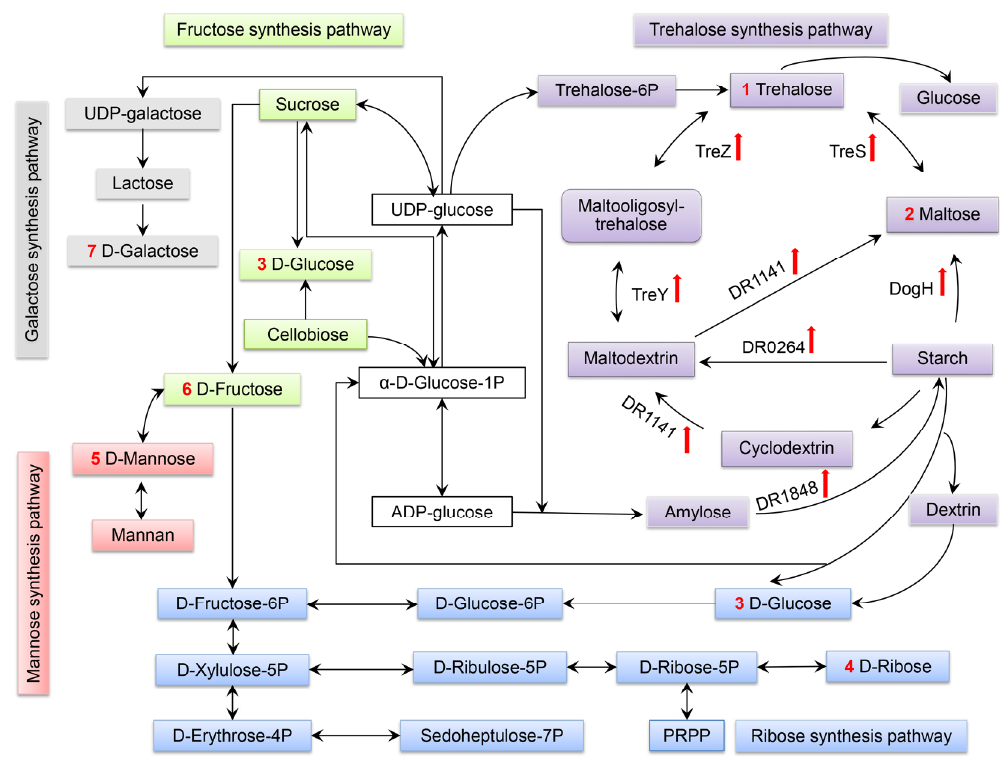
Figure 8. Regulation diagram of carbohydrate osmoregulation pathway. Note: purple pathway: glucose, trehalose and maltose; blue pathway: glucose and ribose; pink pathway: mannose; green pathway: fructose; grey pathway: galactose. The genes and numbers in the remarks indicate the RT-PCR expression amount of related genes in the TreY/TreZ and TreS pathways, under the condition of 1.0 M sorbitol stress treatment for 3 h.